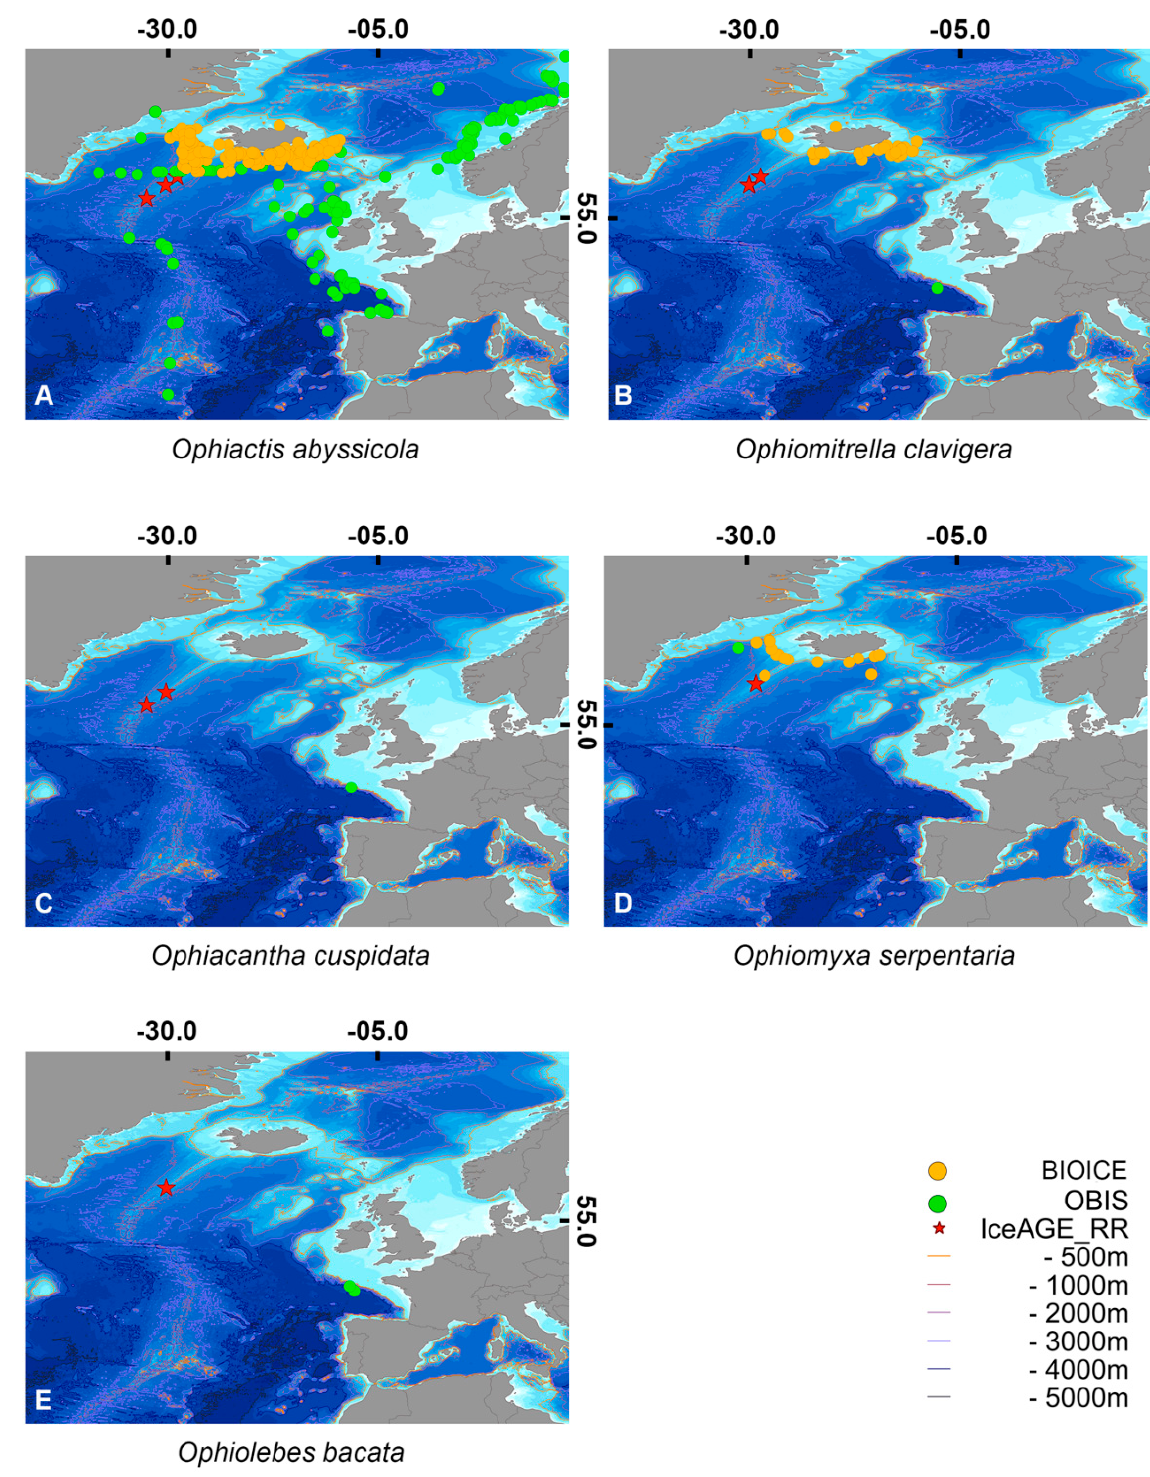
Figure 4. The maps represent the distribution of each ophiuroid species by reference ( A ) Ophiactis abyssicola , ( B ) Ophiomitrella clavigera , ( C ) Ophiacantha cuspidata, ( D ) Ophiomyxa serpentaria , ( E ) Ophiolebes bacata . The red stars indicate the stations where the ophiuroids were sampled during IceAGE_RR. The green dots illustrate the stations that were reported by OBIS (accessed 24 September 2021). The yellow dots are records from BIOICE material.